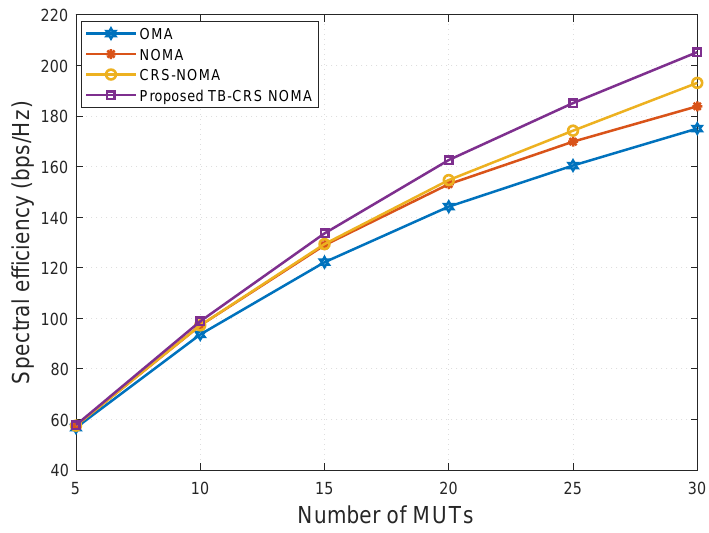
Figure 7. Spectral efficiency versus the number of MUTs when SNR = 20